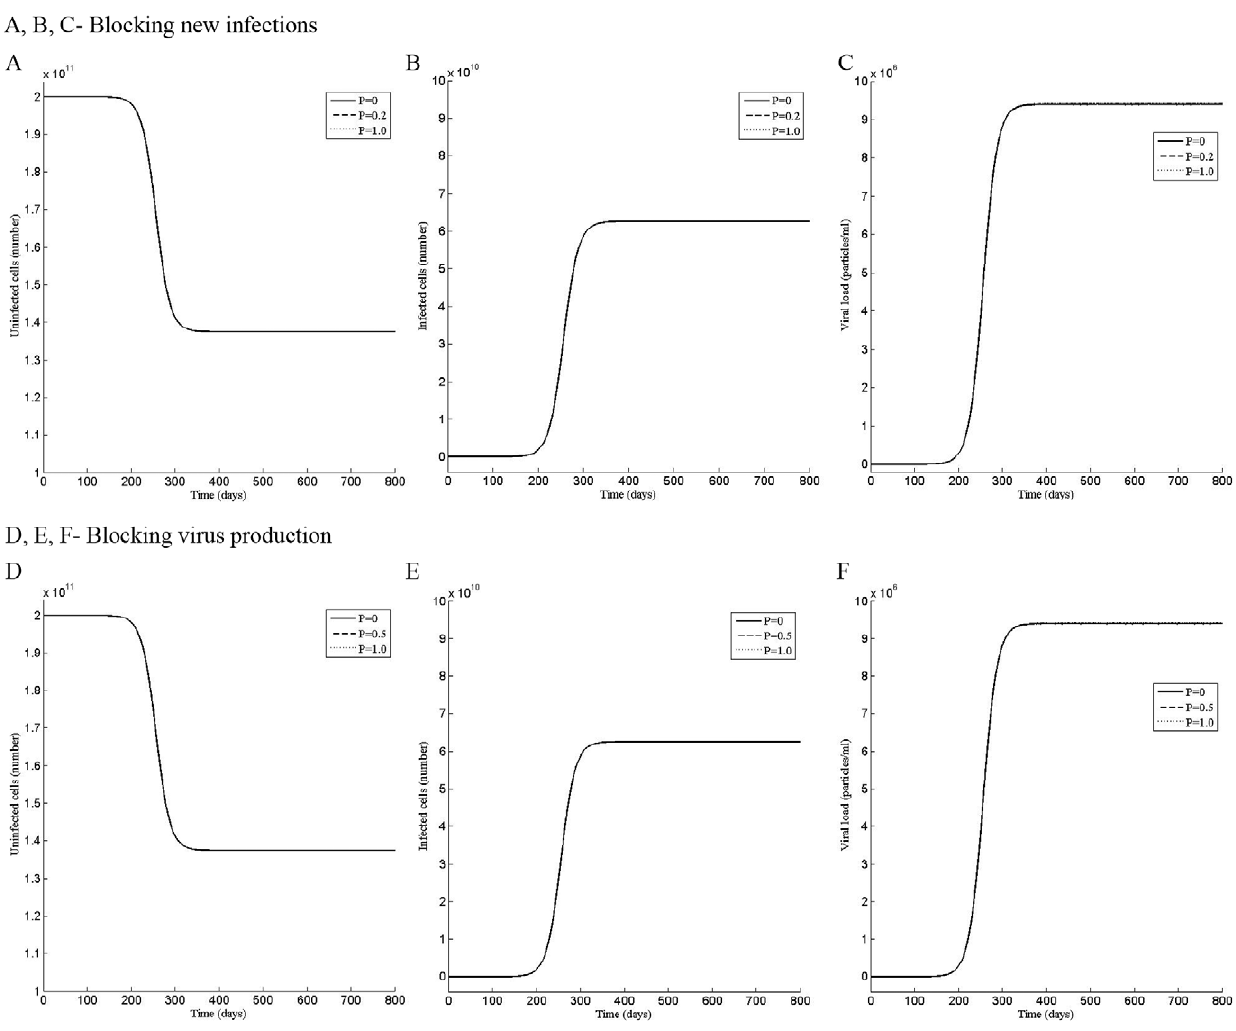
Figure 5. Perturbation in the fourth phase does not alter the steady state of the infection. Dynamics of the (A) uninfected cells, (B) infected cells, and (C) the viral load when the system was perturbed by the dose P of the drug that blocks new infections during the time period t=560 to t=740 day. Dynamics of the (D) uninfected cells, (E) infected cells, and (F) the viral load when the system was perturbed by the dose P of the drug that blocks virus production during the time period t=560 to t=740